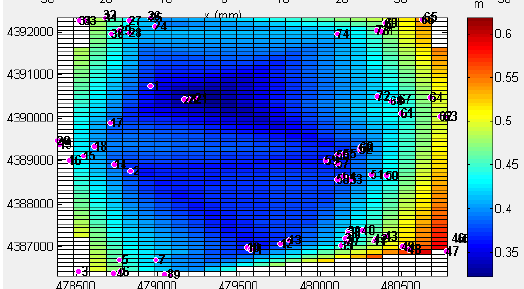
Figure 2.b Distribution of uncertainty for X component for whole stereo model